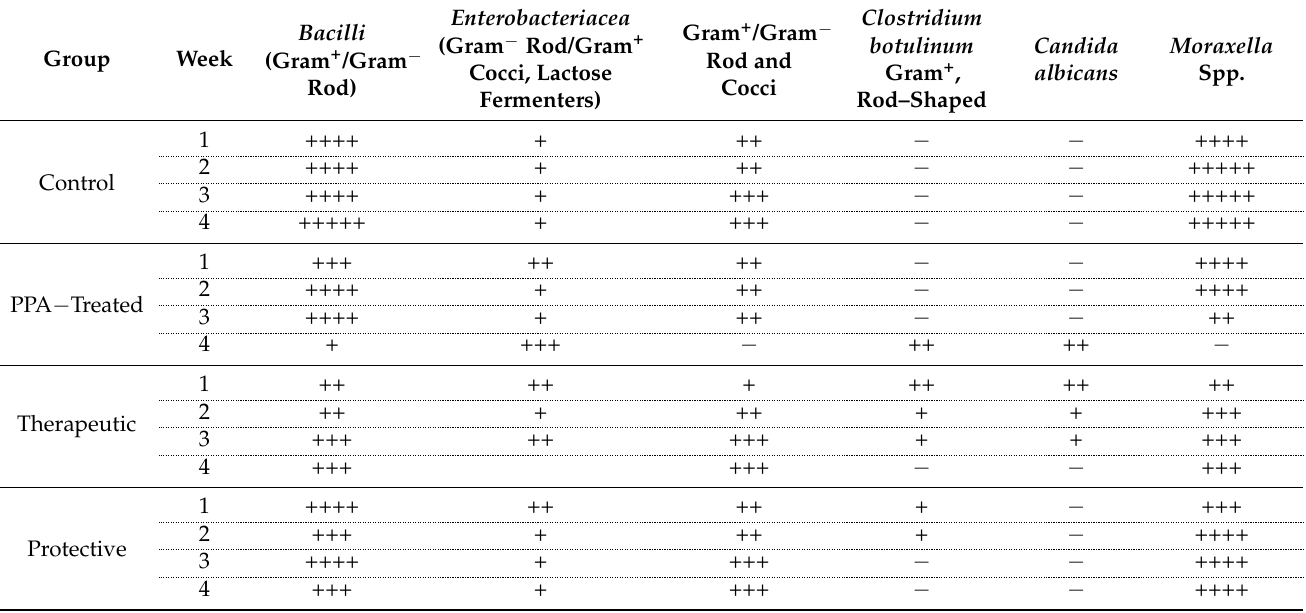
Table 1. Changes in bacteria growth (CFU/g) in the feces of treated rats compared to control